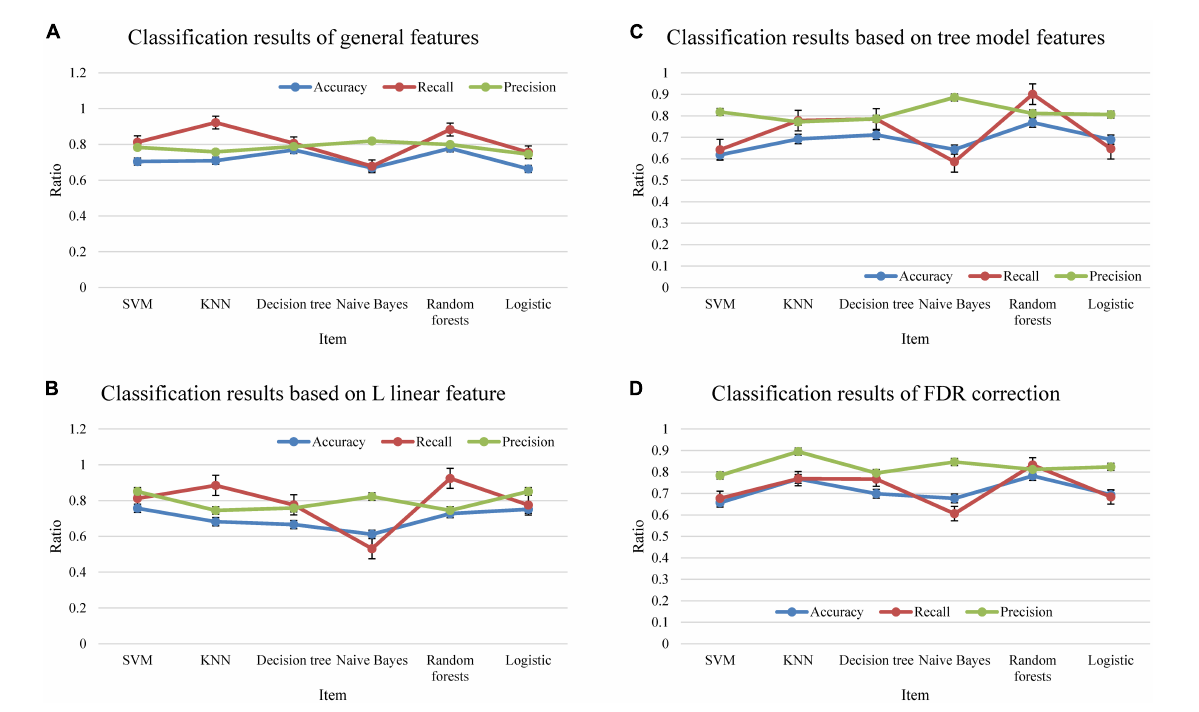
FIGURE3 The classification results. (A) Showed all feature results, (B) showed the linear feature result based on L, (C) was the feature result based on tree model, and (D) showed the FDR correction result.